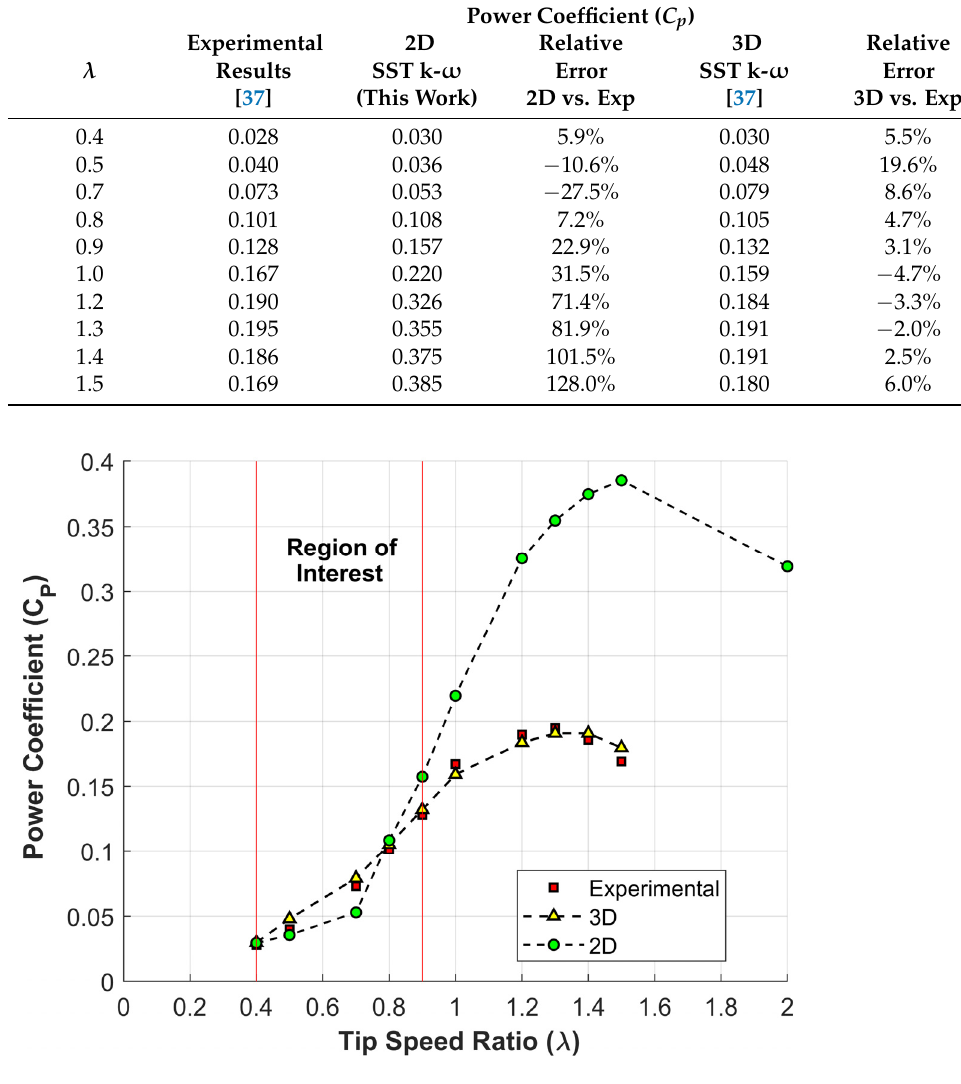
Figure 6. Power Coefficient Changes with Tip Speed Ratio for U ∞ = 8 m/s. (o) 2D Model Used in